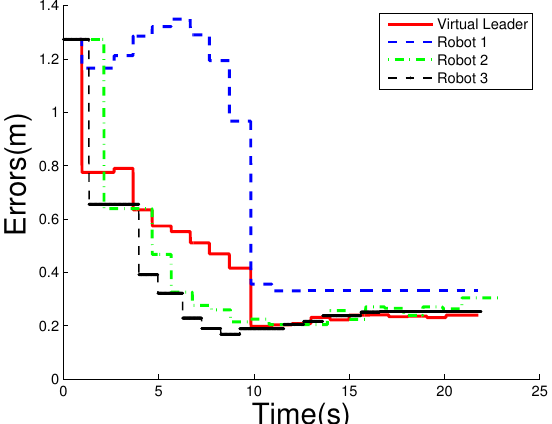
Figure 10. The curves for the localization